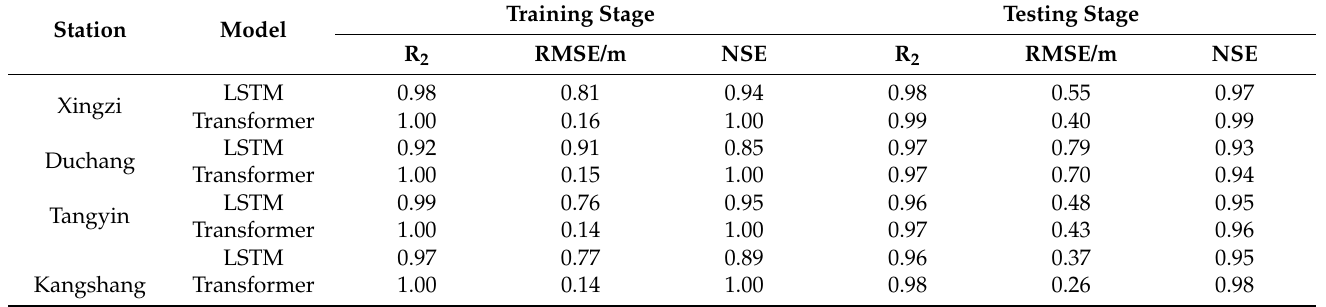
Table 3. Studies applying deep learning models for water level prediction in lakes. Table 4. Comparison of model performances between Transformer and LSTM in four stations.